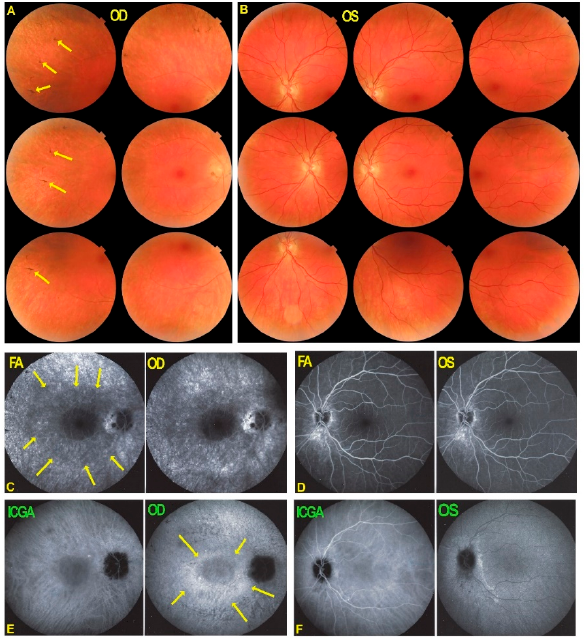
Figure 5. Fundus photographs, FA and ICGA frames ODS in AZOOR patient 1 after 6 years of evolution. The right fundus ( A ) shows an evolution towards pseudo retinitis pigmentosa with a faint bone spicule aspect (yellow arrows). No other manifest changes are visible on the fundus photographs ( A , B ). FA shows discreet late annular hyperfluorescence around the fovea OD ( C , yellow arrows) and increased late hyperfluorescence (window effect/staining) in the more peripheral areas due to chorioretinal atrophy. FA in OS shows hyperfluorescence inferior to the optic nerve (D). ( E , F ) ICGA shows maintained late fluorescence around the normal central area ( E , yellow arrows), indicating preserved choriocapillaris. FA late hyperfluorescence in the periphery had increased substantially over the whole fundus due to atrophic changes of the RPE/choriocapillaris complex which corre- sponded to hypofluorescent areas on ICGA. (Figure 5) The pattern of FAF OD showed an increase of hypoautofluorescent spots in the periphery and within the hyperautofluores- cent ring around the preserved central area indicating atrophic changes of the RPE/chori- ocapillaris complex (Figure 6, white arrows) and corresponding to hypofluorescent spots on ICGA. (Figure 5) Immediately around the preserved central area the more hyperauto- fluorescent rim was interpreted to be due not only to the loss of photoreceptor pigment screen but also to the accumulation of lipofuscin material in RPE cells in an evolving dis- ease with centripetal extension of the process. (Figure 6) The FAF aspect in the left eye had not changed notably. This case fulfilled the characteristics of AZOOR. The multimodal imaging findings clearly indicated that the pathology resided at the level of the retina with a preserved choriocapillaris followed only later by areas of secondary choriocapillaris loss.